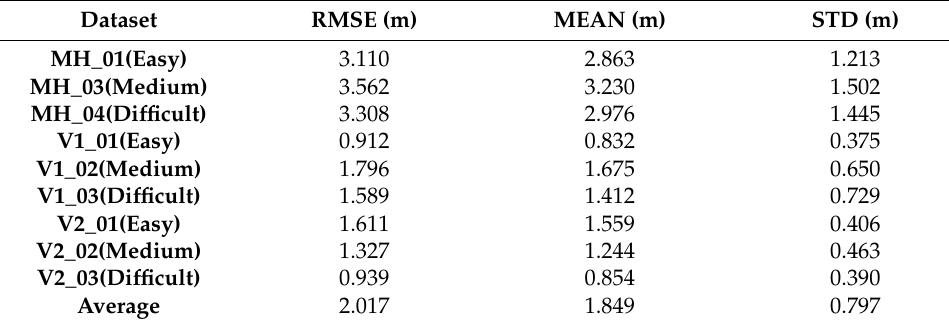
Table 7. Absolute translation RMSE, mean, and standard deviation.